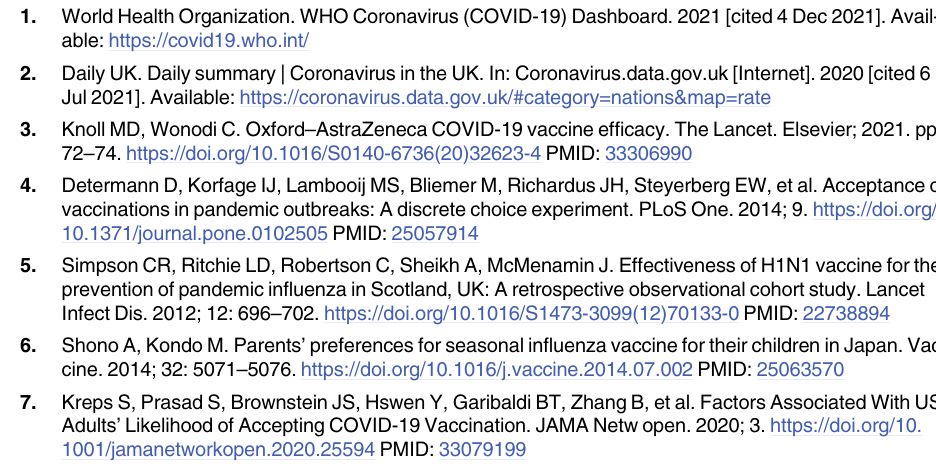
S1 Fig. Vaccine choice and preference gap across experimental treatments, not black or latino. Note : Panel A: Circles indicate the percentage choosing Vaccine A, a one-shot, viral vector vaccine with efficacy data mirroring that reported in the Janssen vaccine trials. Squares indicate the percentage choosing Vaccine B, a two-shot, mRNA vaccine with efficacy data mir- roring that reported in the Pfizer vaccine trials. Panel B: Circles indicate the preference gap between Vaccine A and Vaccine B. Horizontal bars present 95% confidence intervals about each mean